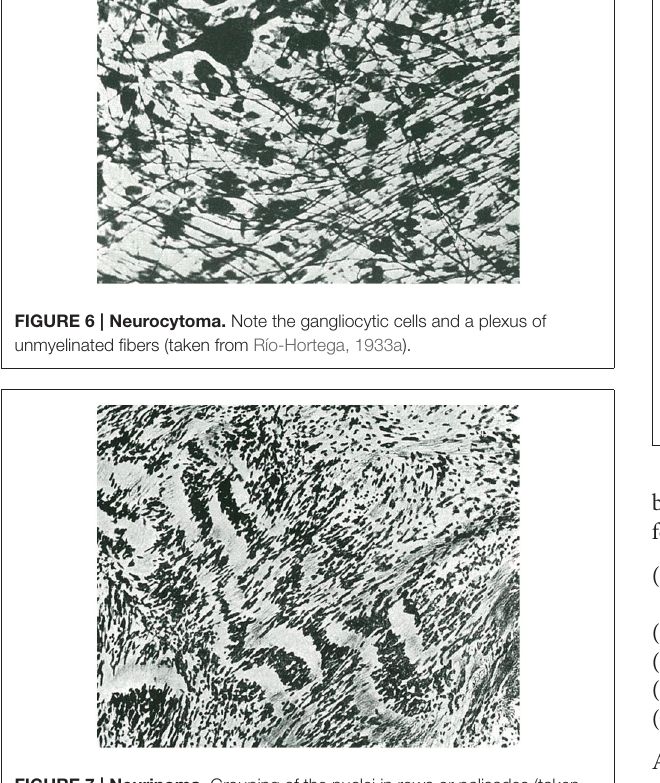
(1) Tumors of neuroepithelial tissue, including astrocytoma, glioblastoma multiforme,